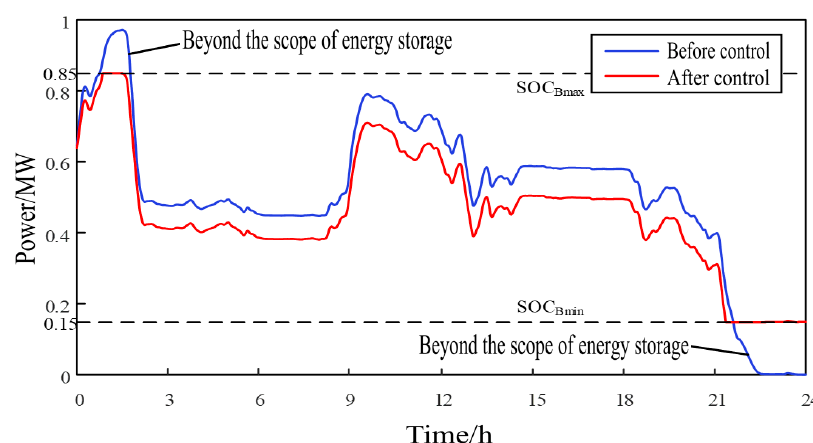
Figure 8. Comparison of battery SOC before and after control.